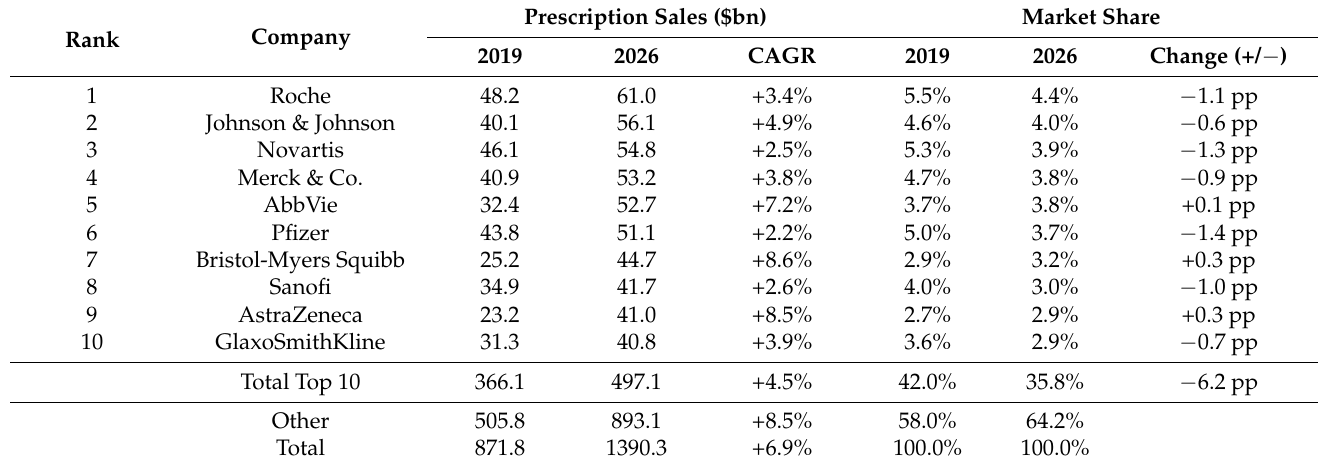
Table 1. World Prescription Drug Sales (2019–2026): Top 10 Companies and Total